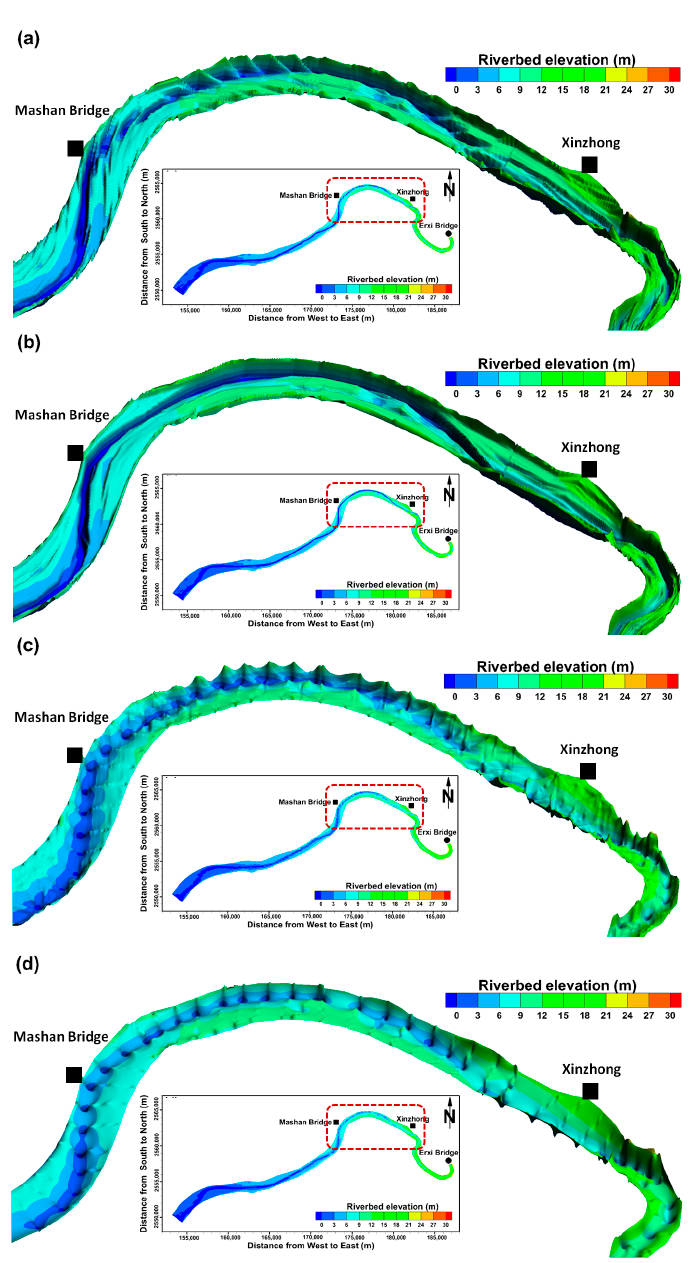
Figure 5. River bed elevation used for hydrodynamic modeling: ( a ) original cross-sectional data; and resampled cross-section data using: ( b ) the interpolation method; ( c ) the inverse distance weighting (IDW) method; and ( d ) the natural neighbor (NN) method.